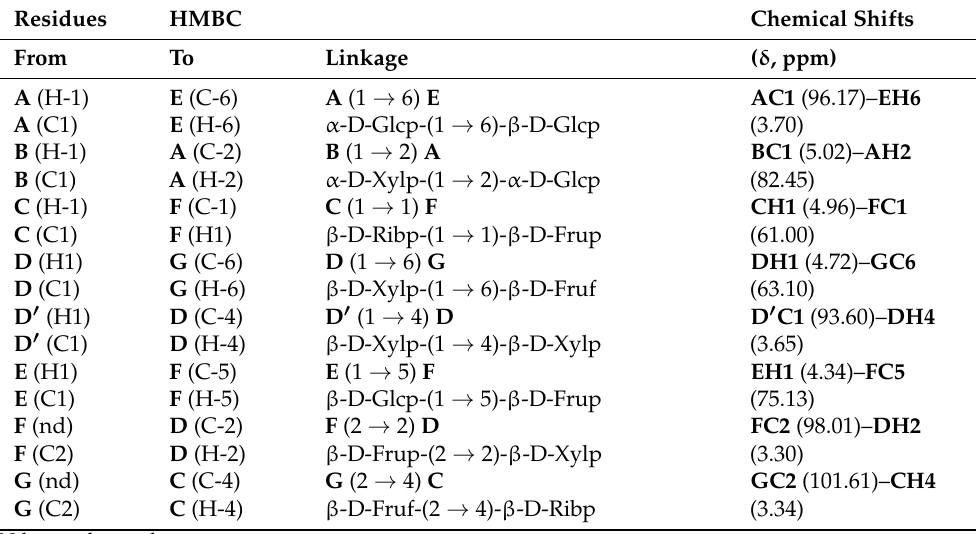
Table 4. Inter-residue correlations from the anomeric atoms observed in 1 H and 13 C HMBC